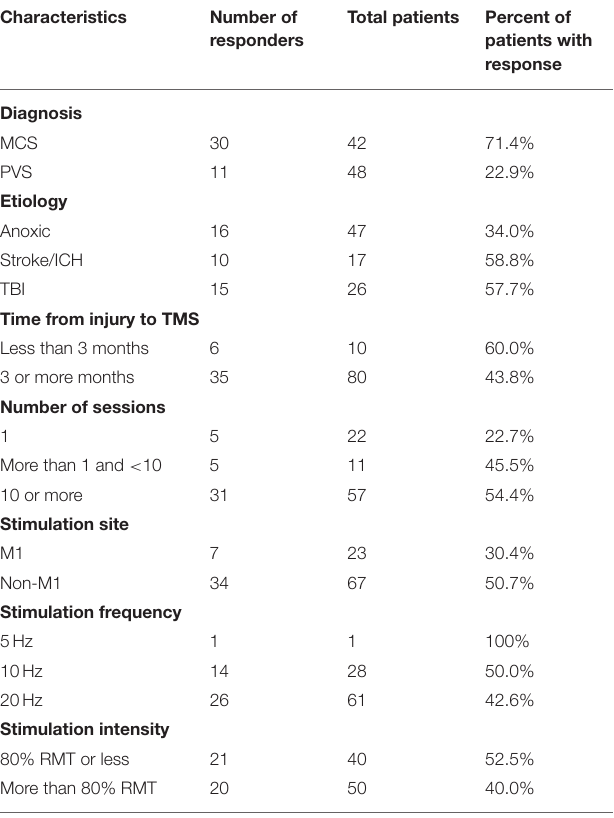
TABLE 2 | Overview of patient and protocol characteristics with number of responders.